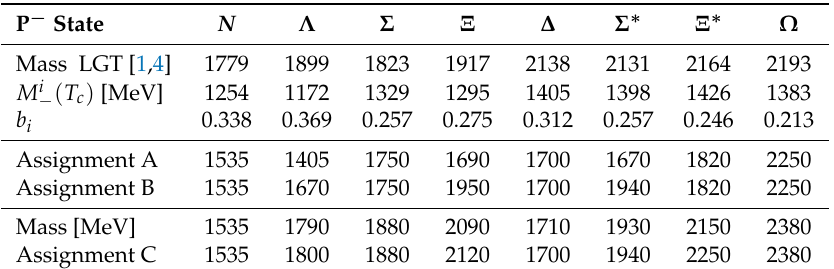
Table 1. Assignment of the negative-parity states in in-medium HRG